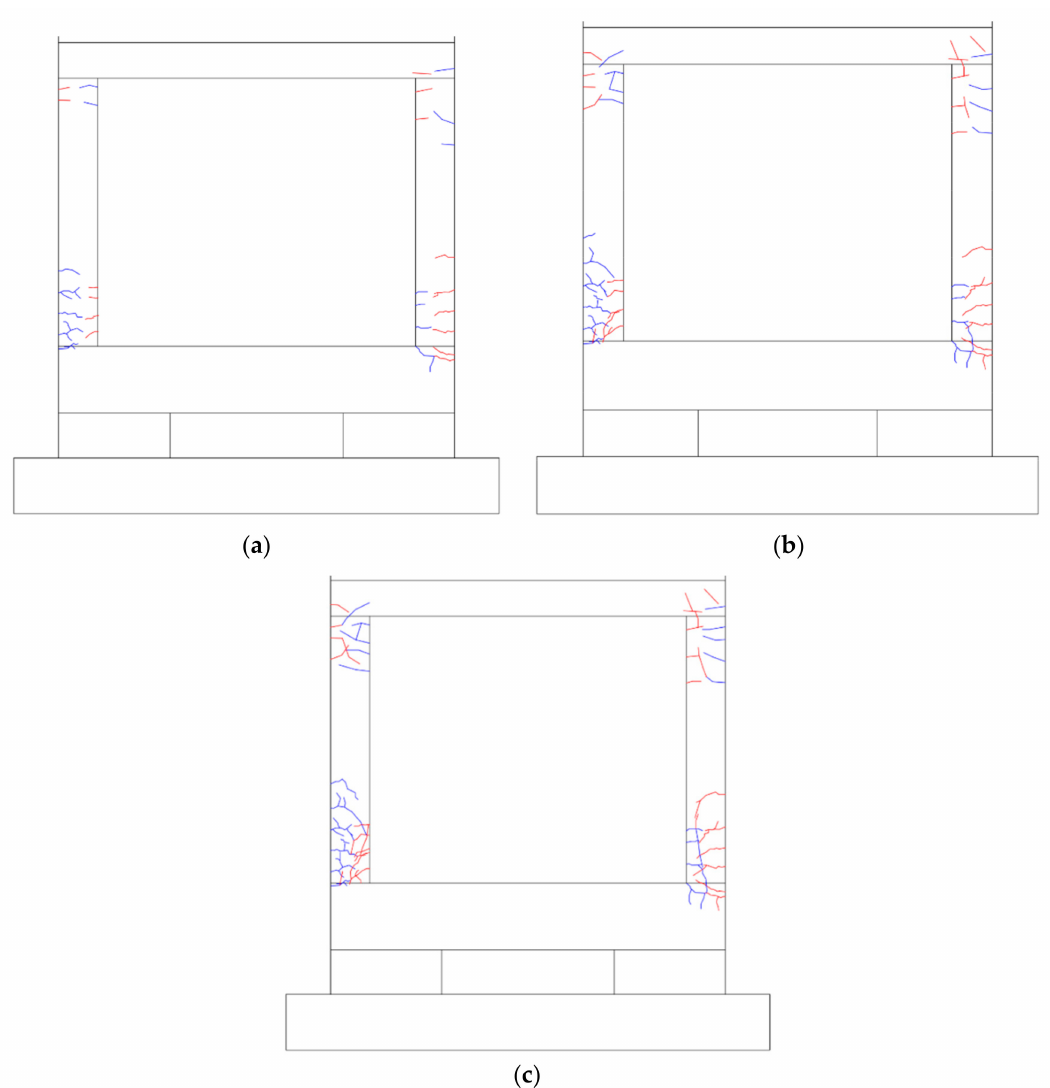
Figure 19. Cracks of test frame retrofitted with NBSD-WSCS (PD-NBSD-WSCS) at the final stage of the test; ( a ) 200 cm/s 2 ; ( b ) 300 cm/s 2 ; ( c ) 400 cm/s 2